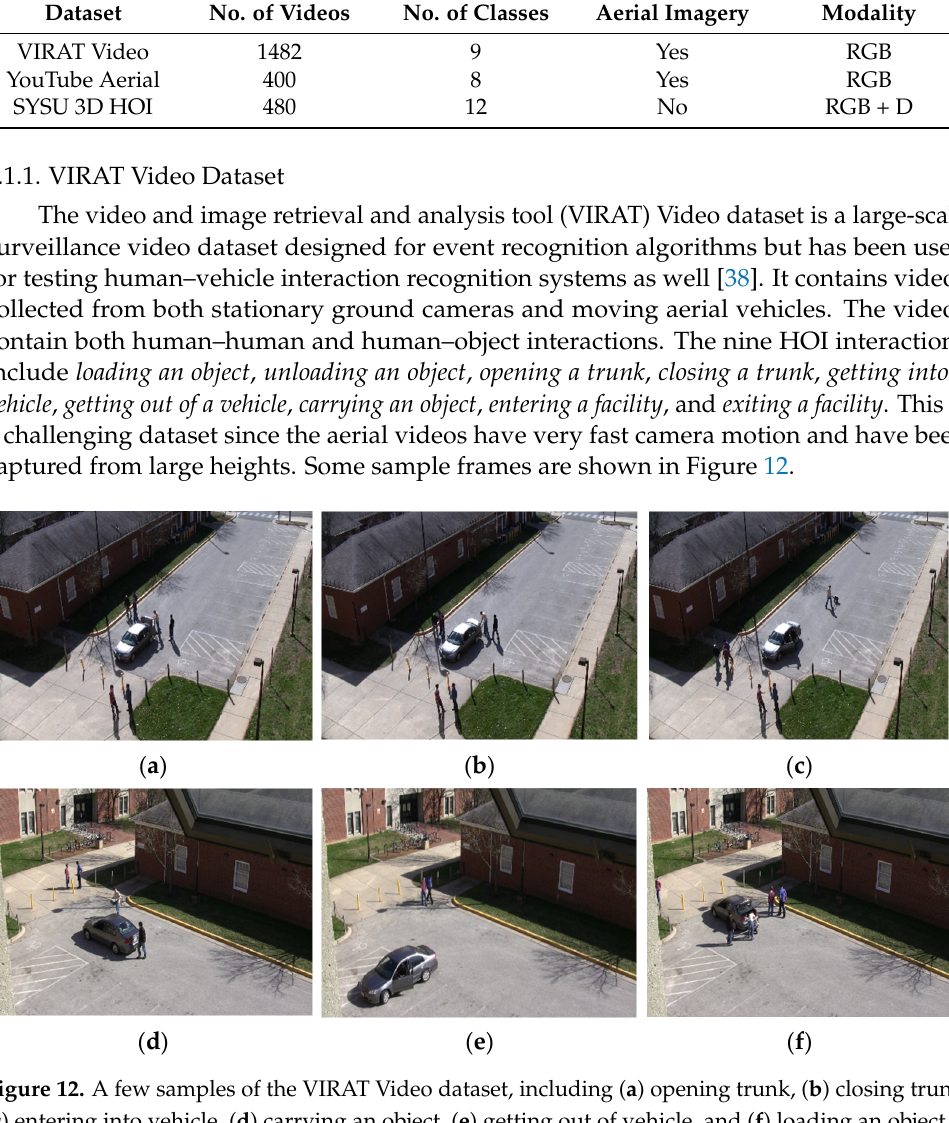
Table 3. A summary of the datasets used for experimentation.